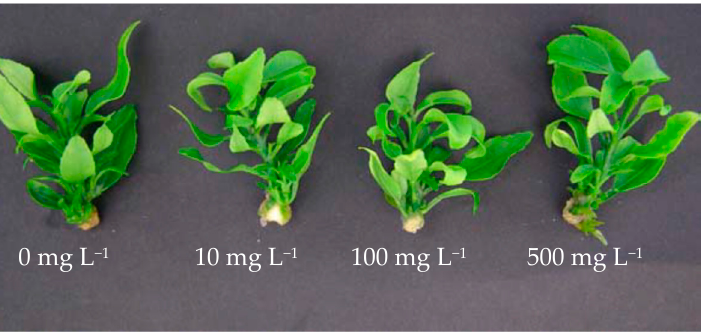
Plants 2021 , 10 , 1321 Figure 2. Shoots of the mandarin ‘Fortune’ grown at different concentrations of Alternaria citri toxin.